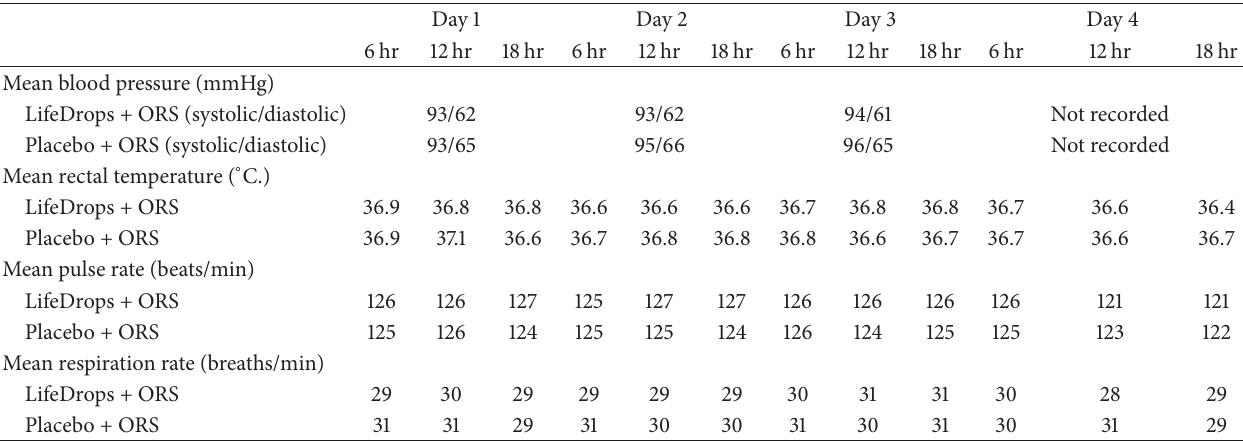
Table 5: Mean blood pressures, rectal temperatures, pulse rates, and respiration rates over 4 days of subjects 2 to 5 years old consuming either LifeDrops solution in ORS or water (as a placebo) in ORS. Measurements were taken three times each day.